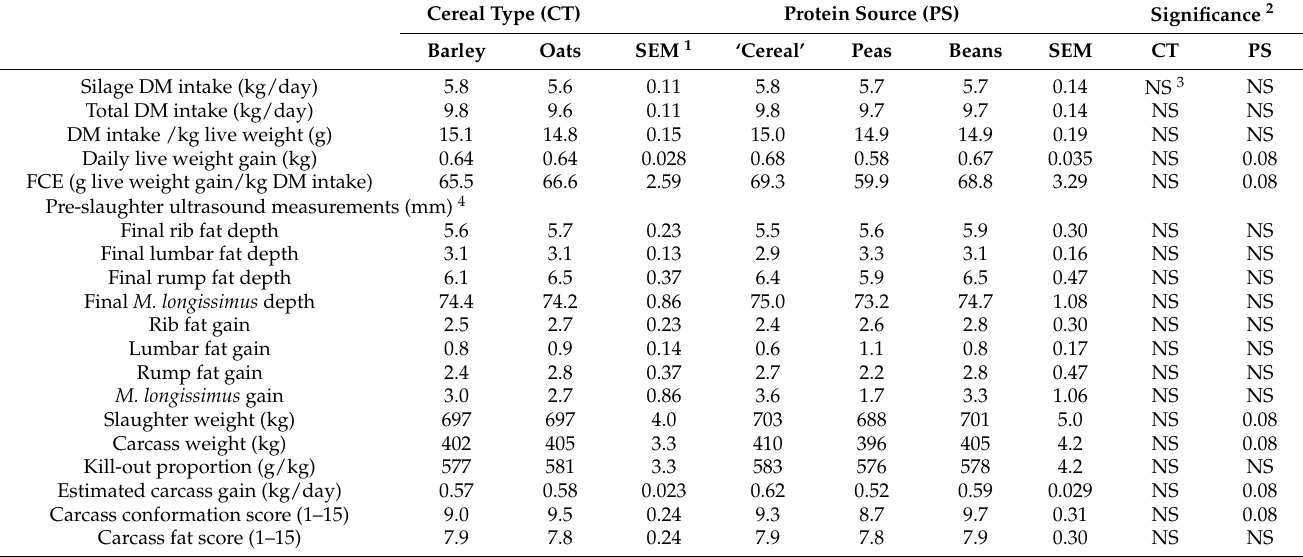
Table 6. Effects of cereal-based concentrate type and protein source on dry matter (DM) intake, growth, feed conversion efficiency (FCE), ultrasonic measures of body composition and carcass traits of steers in Experiment 2.